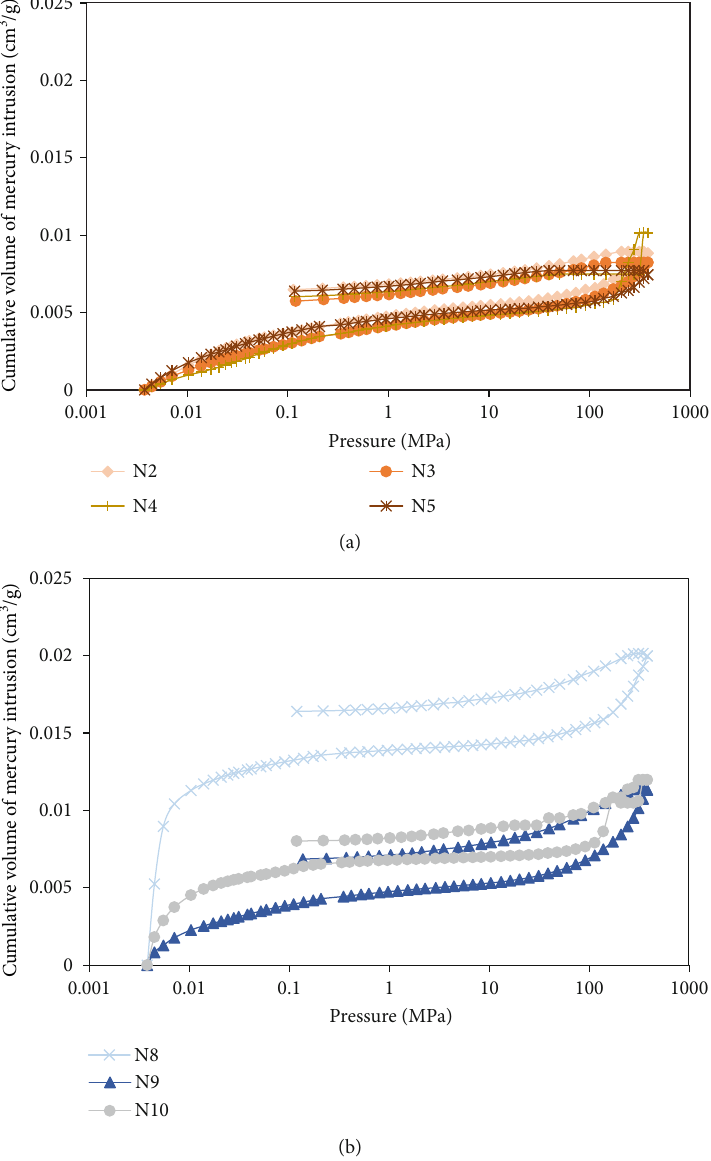
Figure 15: Mercury injection curves for Wufeng-Longmaxi shales. The mercury intrusion curves exhibit two di ff erent trends in studied samples, which are presented in (a, b). (a) Types of samples N2 to N5 with relatively lower TOC contents. The volume of mercury intrusion fi rst increases (0.01 – 1MPa) and is then kept stable (1 – 400MPa). (b) Types of samples N8 to N10 with higher TOC contents. The volume of mercury intrusion shows a rapid increase (0.01 – 1 MPa), a relatively stable phase (1 – 50MPa), and a rapidly increasing phase (50 – 400